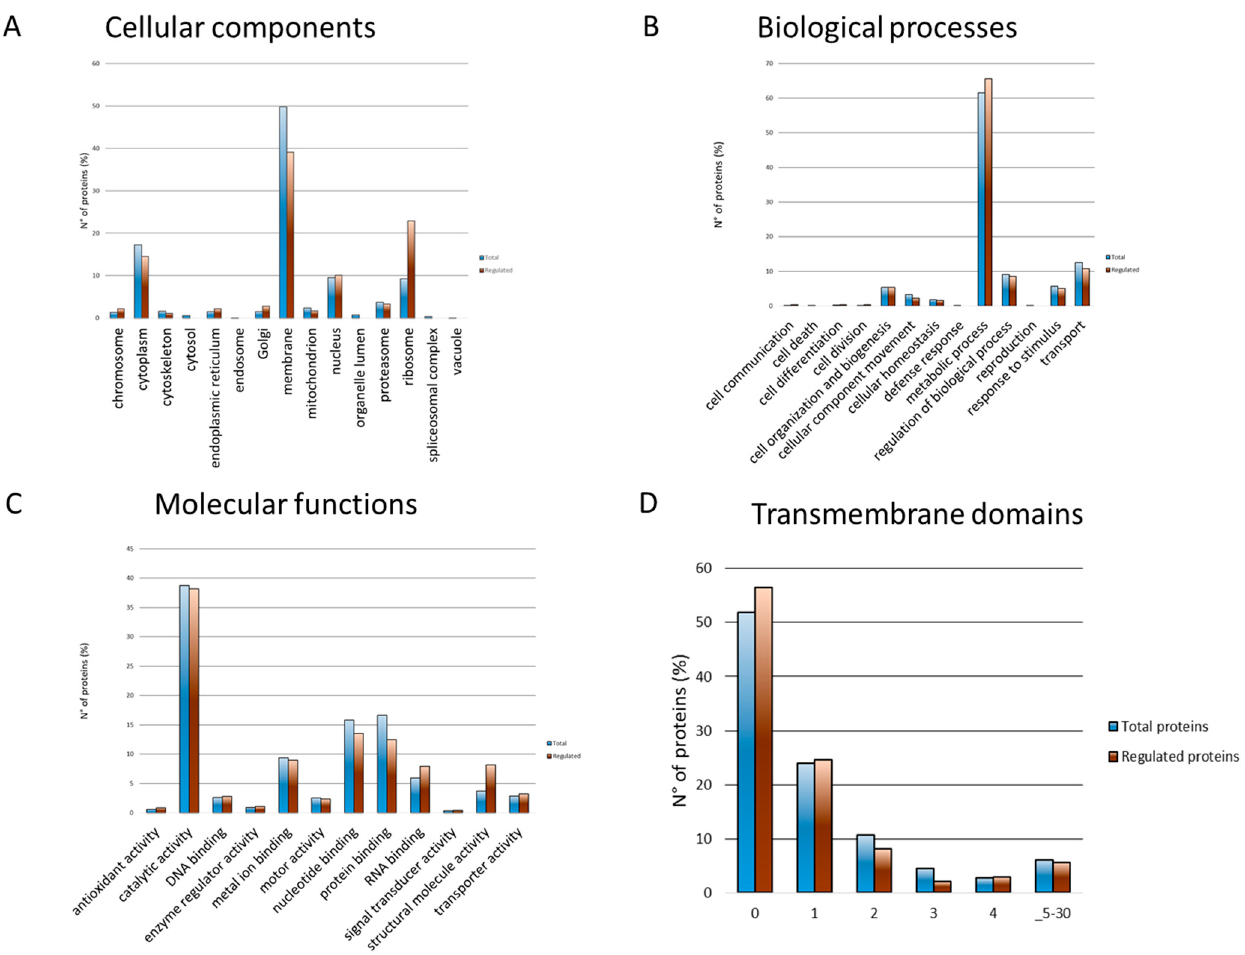
Figure 5. Gene ontology (GO) analysis and transmembrane domains of total and regulated proteins. ( A ) Cellular components, ( B ) biological processes, and ( C ) molecular functions were compared between the total and the regulated proteins. ( D ) Transmembrane domains were assigned to the total and regulated proteins. The gene ontology and transmembrane domain data were obtained using Protein Center software (Thermo Fisher).